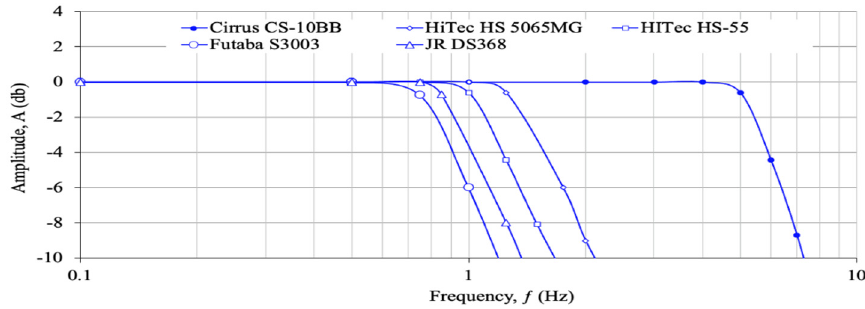
Figure 1. Bode Amplitude Plot of five Common Sub-Submicro Scale Actuators [2].